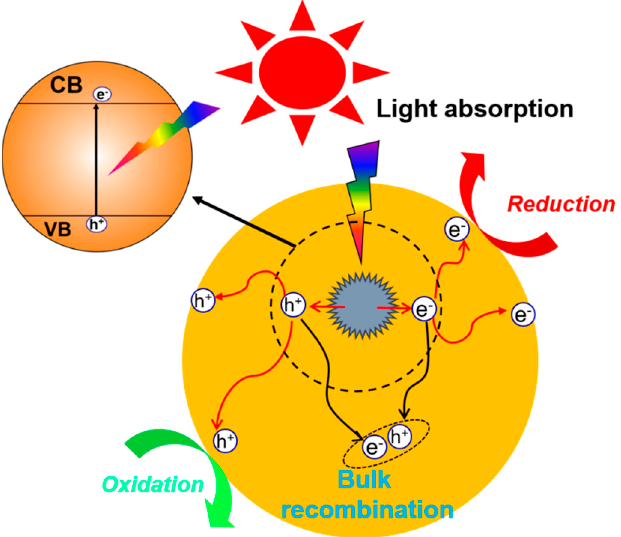
Figure 2. Simulation of semiconductor photocatalysis under light irradiation.